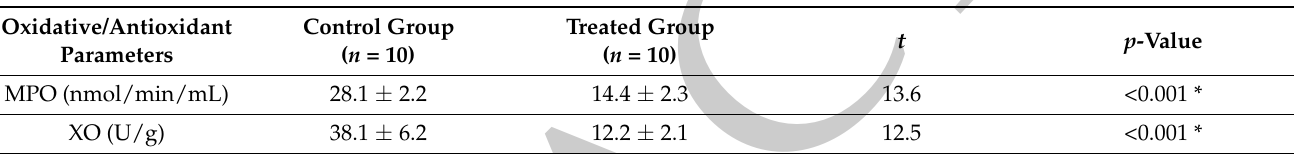
Table 4. Changes in MPO and XO of the control diabetic rats with deep wounds and the rats treated with the Combretum molle